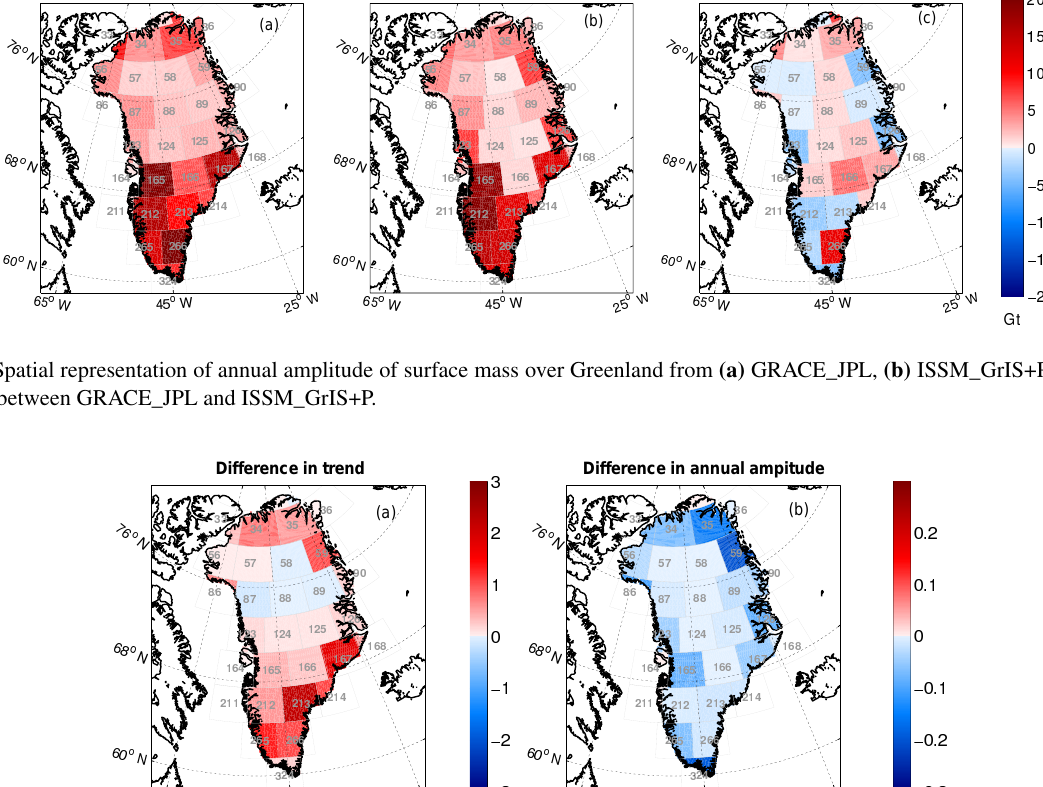
shavn Isbræ) the models result in a smaller negative trend by about 15 Gt yr − 1 , and in mascon 212 the models result in a larger negative trend by about 10 Gt yr − 1